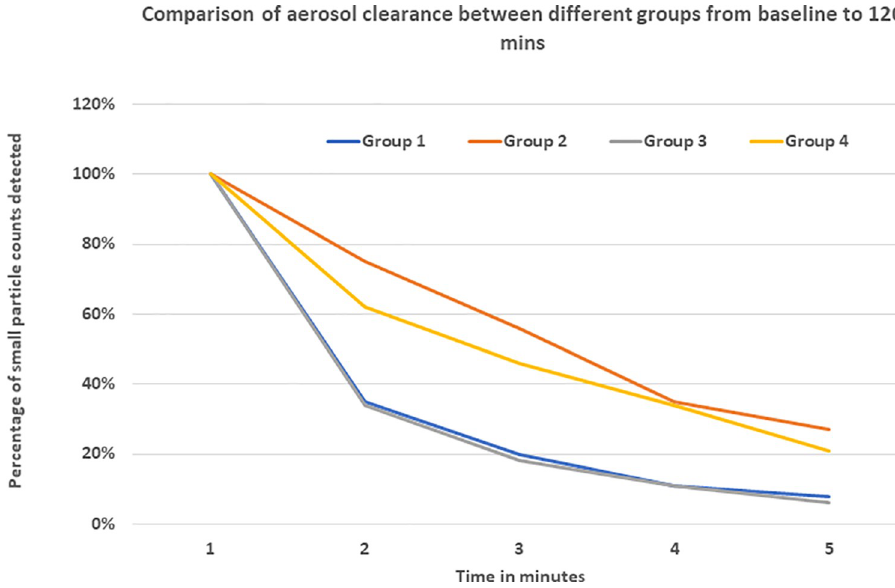
Fig 6. Comparison of aerosol clearance between different groups from baseline to 120